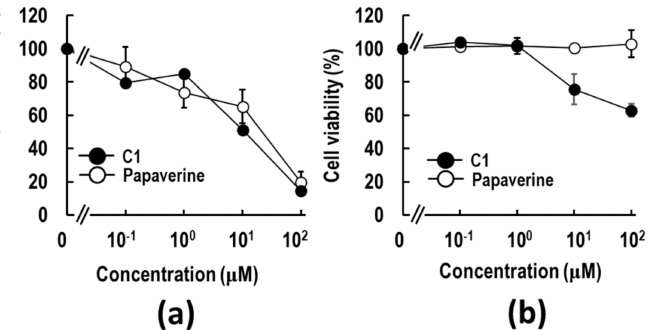
Figure 1. The screening of papaverine-mimetic 3-styrylchromone derivatives by 3D pharmacophore using LigandScout. ( a ) Anti-inflammatory effects of C1 and papaverine. RAW264.7 cells were pre- treated with C1 (closed circle) or papaverine (open circle) for 2 h, followed by stimulation by 5 µ g/mL HMGB1. After 18 h of incubation, IL-6 release in the medium was measured by ELISA. ( b ) RAW264.7 cells were pre-treated with C1 or papaverine for 2 h, followed by 5 µ g/mL HMGB1 for 18 h. The cell viability was determined by the WST-8 assay as described in Section 4. The data are presented as mean ± SE of four independent